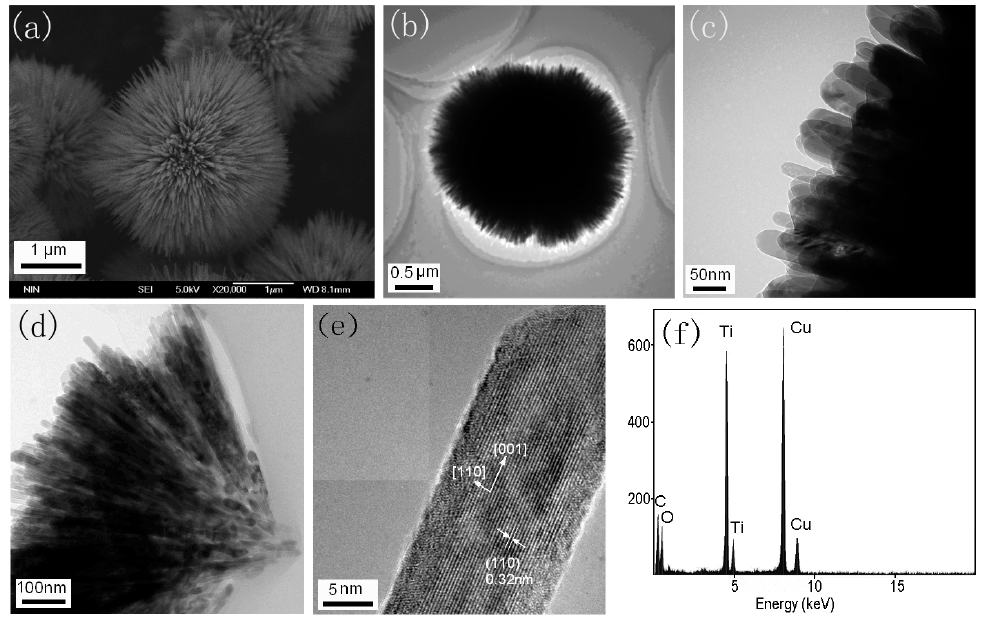
Figure 8. SEM image ( a ), TEM images ( b – e ), and EDS ( f ) of the urchin-like hierarchical TiO 2 [30].